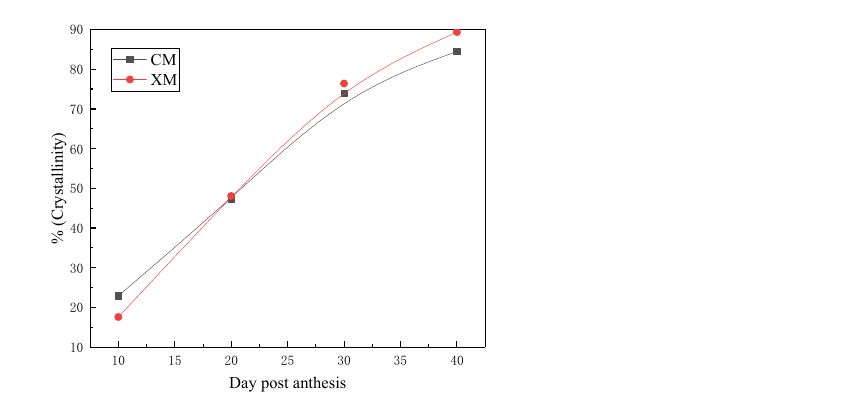
Figure 4. Crystallinity percentage of fibers harvested from CM and XM at different growth stages.